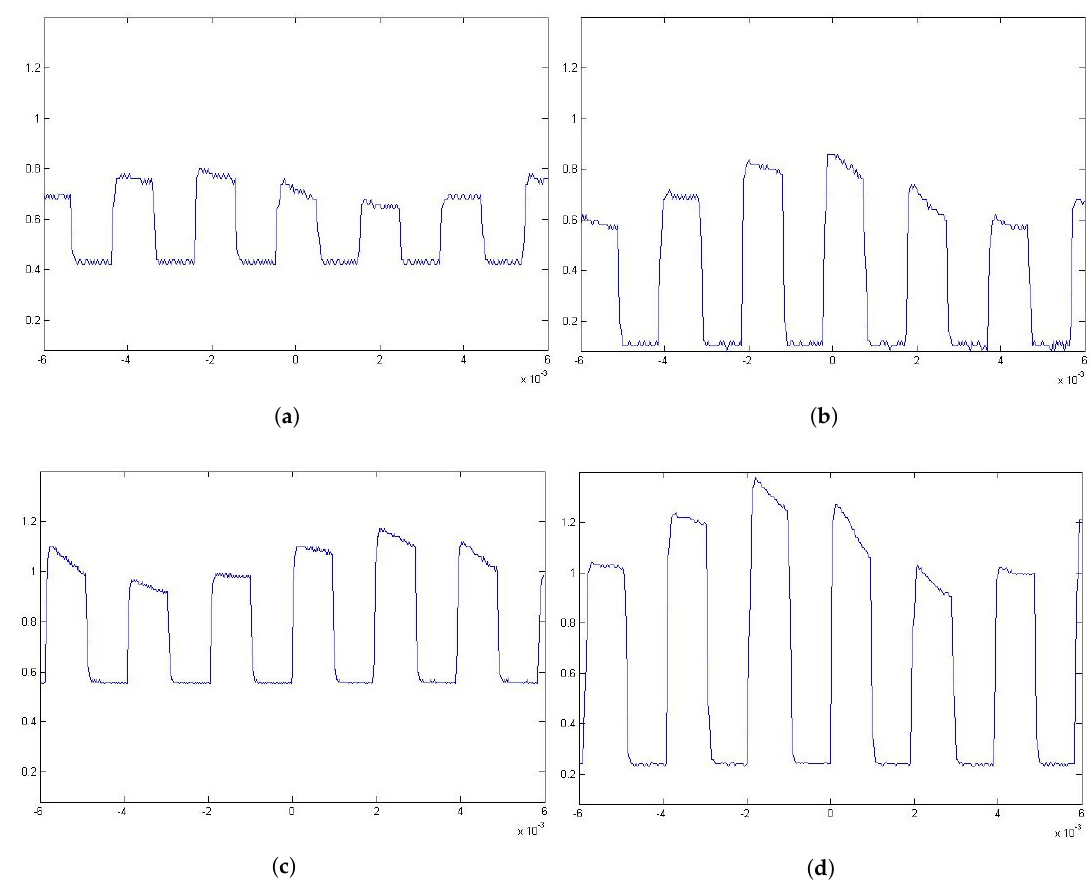
Figure 10. Subfigures ( a , b ) are measures taken from location T2 being ( a ) a case in which the windows are present between the emitter and the receiver and ( b ) a case in which the windows are not present between the emitter and the receiver. Subfigures ( c , d ) are measurements taken from location T4 being ( c ) a case in which the windows are present between the emitter and the receiver and ( d ) a case in which the windows are not present between the emitter and the receiver. In all cases, the positions are as defined in Table 2. Vertical axes denote power in nW and the horizontal axes denote time in s.